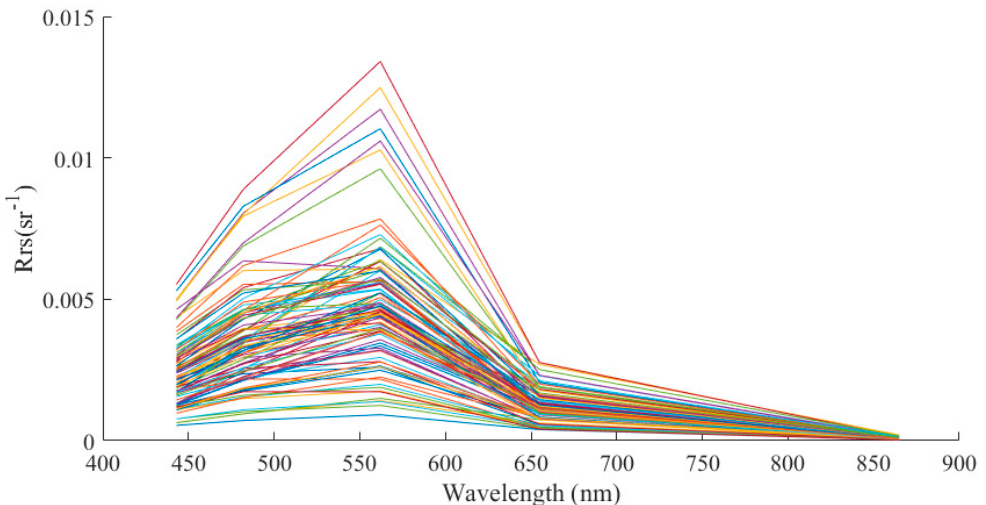
Figure 2. Rrs spectra. Each line represents Rrs spectrum from each